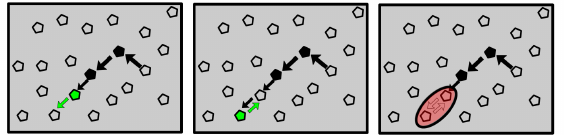
Figure 3. Formation of a new area. Source: Authors Adjusting